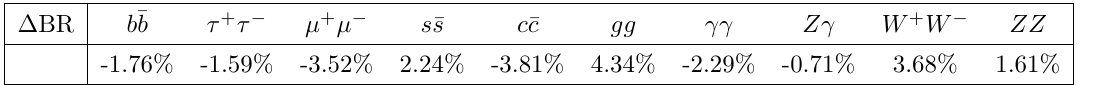
Table 7 . Relative size of the EW corrections to the BRs of the SM Higgs boson H SM with mass m H = 125 : 09 SM